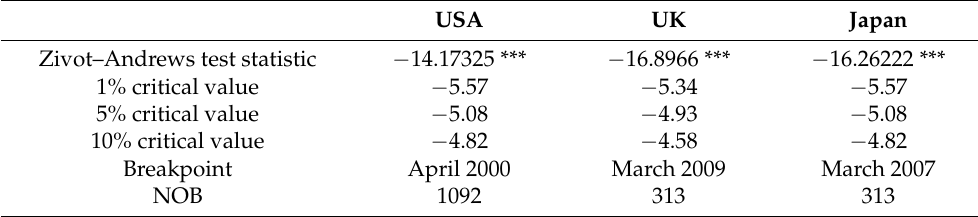
Table 5. Single-break unit root tests: Zivot–Andrews